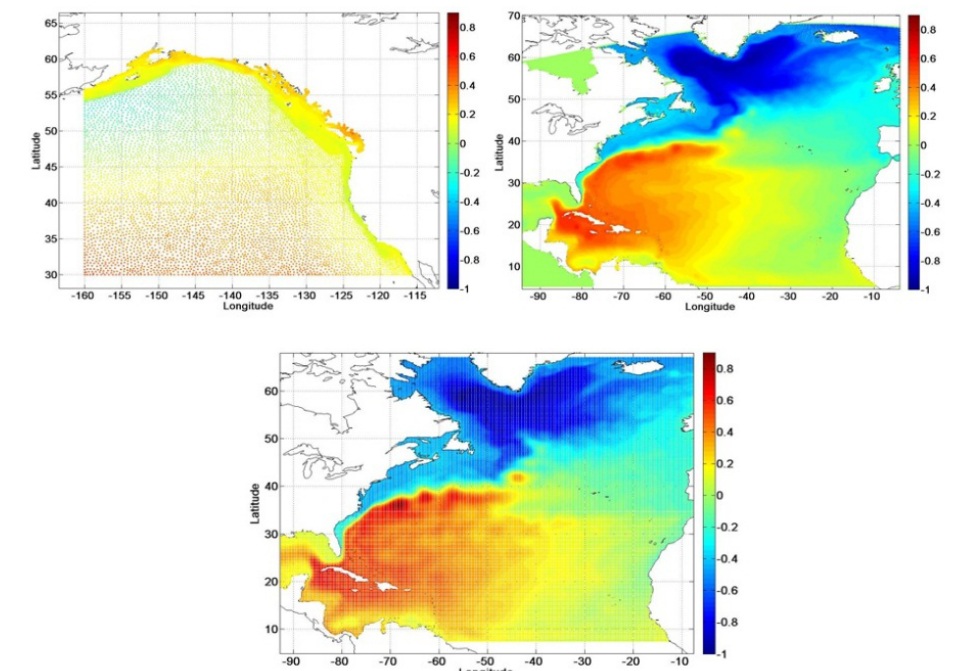
Figure 2. Regional oceanic models with SST values in meters (Top Left: Foreman Top Right: Wright Bottom: Thompson & Demirov).